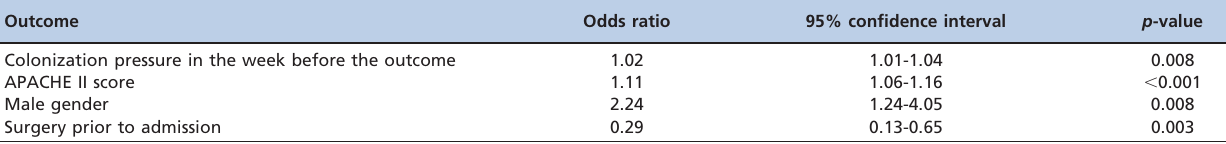
CRPA: carbapenem-resistant P. aeruginosa ; MRAC: multiresistant Acinetobacter